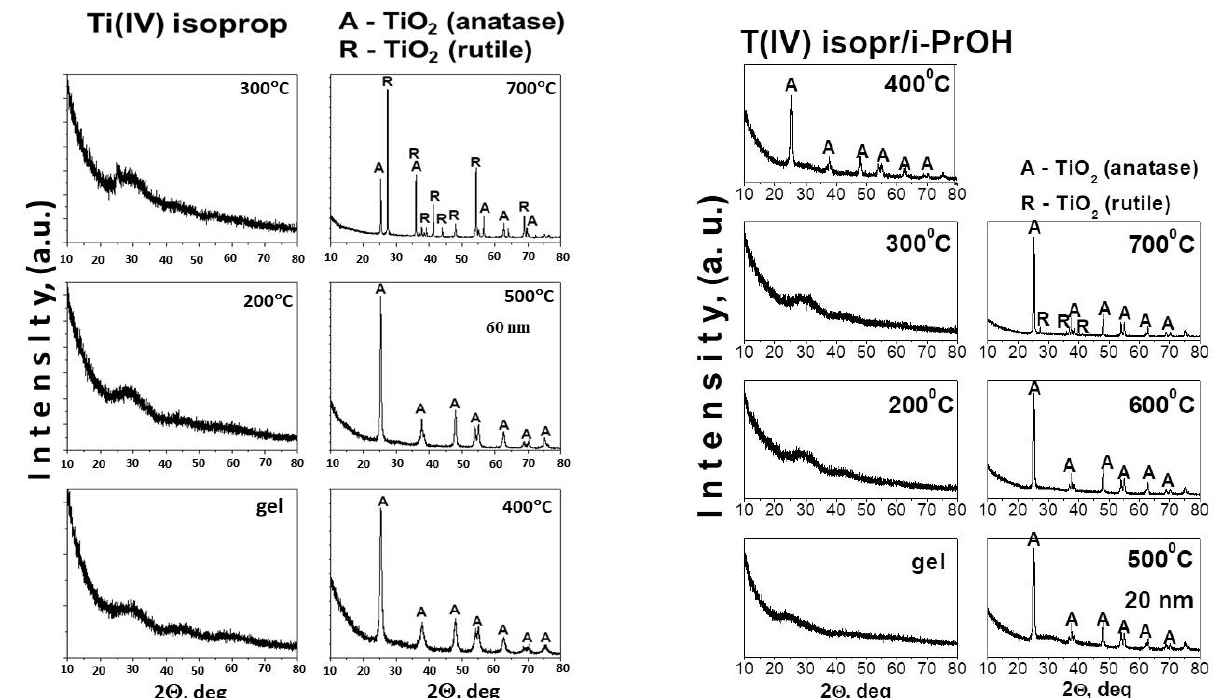
Figure 3. XRD patterns of used precursor Ti(IV) isopropoxide (TTIP) and TTIP dissolved in i-PrOH: (A) TiO 2 -anatase, (R) TiO 2 -rutile.